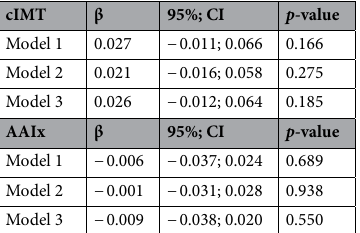
Table 2. Association of sCAIX with cIMT and AAIx. Linear regression analysis using 504 and 541 participants that underwent cIMT and AAIx measurement, respectively. sCAIX was treated as dichotomous independent variable (detectable yes/no). β indicates mutation of dependent variable if CAIX is detectable (yes). Model 1: Crude, no adjustments. Model 2: model 1 + adjustment for sex and age. Model 3: model 2 + adjustments for smoking (status [current, former, never] & packyears), medication (lipid-modifying y/n, anti-HT y/n, glucose- lowering y/n), glucose metabolism status (IGM y/n, DM2 y/n).